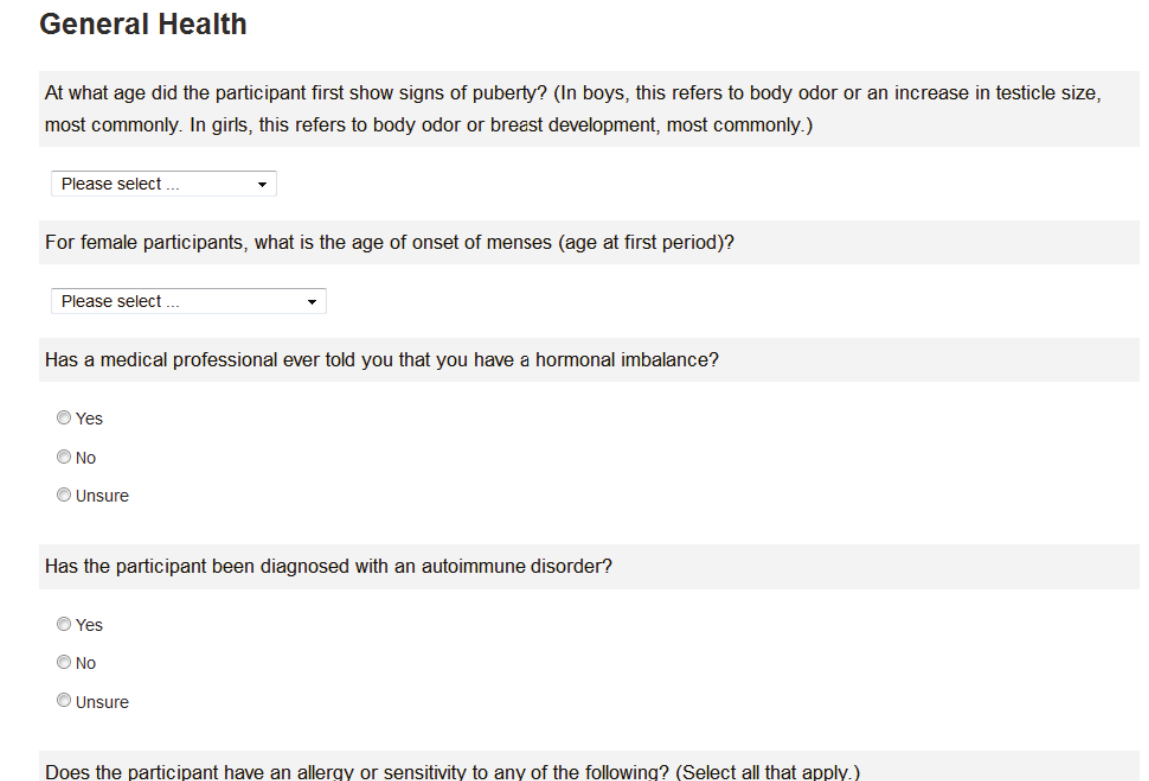
Supplemental Figure 3. General